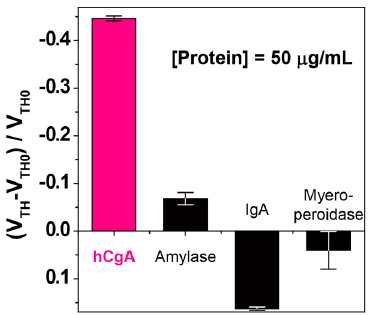
Figure 3. Changes in the threshold voltage ( V TH ) of the OFET by the proteins at various concentrations in a PBS solution with 0.1 wt % HSA. [Protein] = 50 µg/mL. Five repetitions were measured for each analyte.